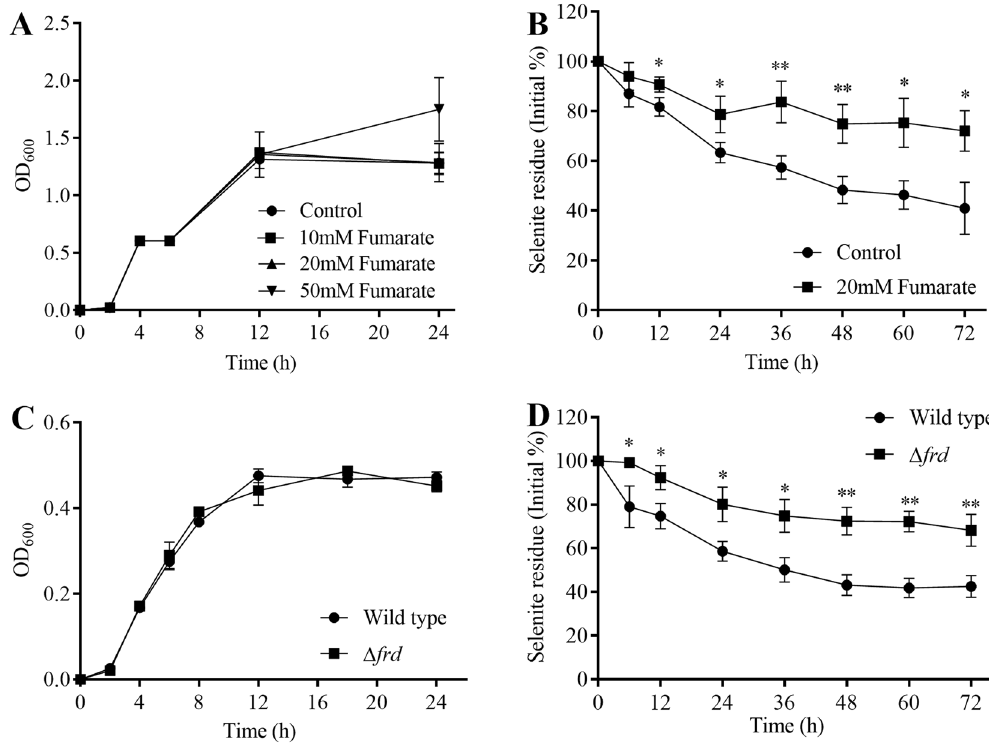
Figure 6. Effect of fumarate reductase on selenite reduction in E. cloacae Z0206. ( A ) Effect of fumarate on the growth of E. cloacae Z0206. The bacteria were cultured with the addition of 10 mM, 20 mM, or 50 mM fumarate or without the presence of fumarate; the OD 600 values were measured at the indicated time point after 3-fold dilution. ( B ) Effect of fumarate on the selenite reduction rate. The bacteria were cultured in the presence of 5 mM selenite with or without 20 mM fumarate treatment. Samples were collected at different time points and centrifuged at 4 °C at 10,000 × g for 10 min, and the supernatant was used to determine the selenite residue. The selenite residue was converted to a percentage of the initial selenite concentration. ( C ) Effect of fumarate reductase mutation on the growth of E. cloacae Z0206. ( D ) Effect of fumarate reductase mutation on the selenite reduction rate in E. cloacae Z0206. * P < 0.05, ** P < 0.01 (n = 3), compared with the selenite residue of the control group or the wild-type group at the same